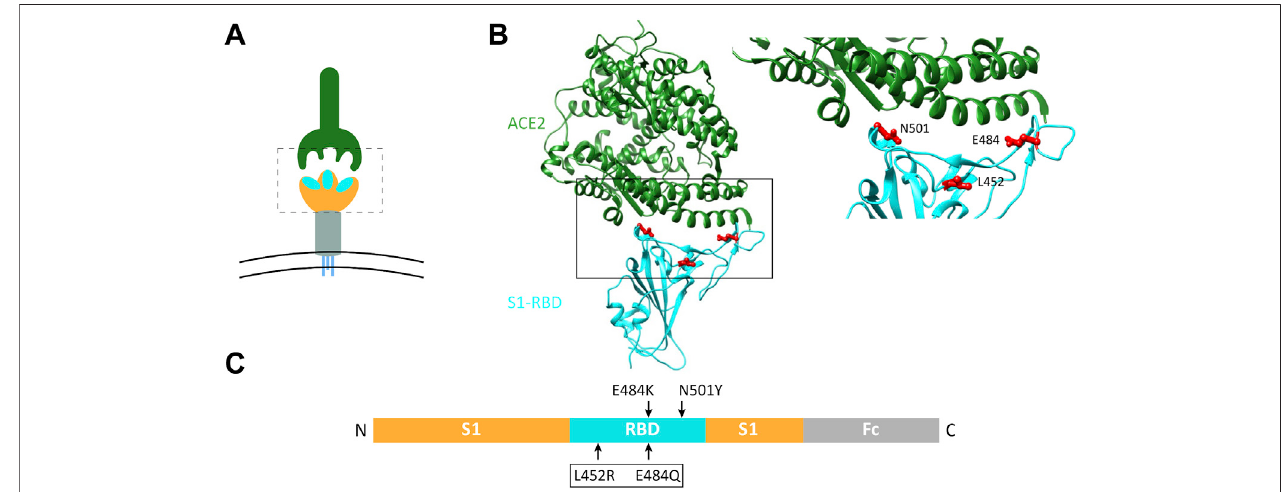
FIGURE 1 | Schematic representation of the host ACE2 receptor and spike RBD variants analyzed in this study. (A) Three-dimensional (3D) representation of coronavirus spike protein (lower graphic) and the host ACE2 receptor (upper graphic). Spike protein forms a homotrimer with three S1-RBD heads (enclosed in dotted box). (B) StructuralmodelofSARS-CoV-2RBD(cyan)interactingwithhumanACE2(darkgreen),basedonPDB6m0j(Lanetal.,2020).Theareabordered bytheboxis magni fi ed on the right to show the sites of mutations analyzed in the current study. (C) Linear representation of the Fc-tagged S1 cDNA plasmid used. Arrows indicate sites of mutated amino acids.